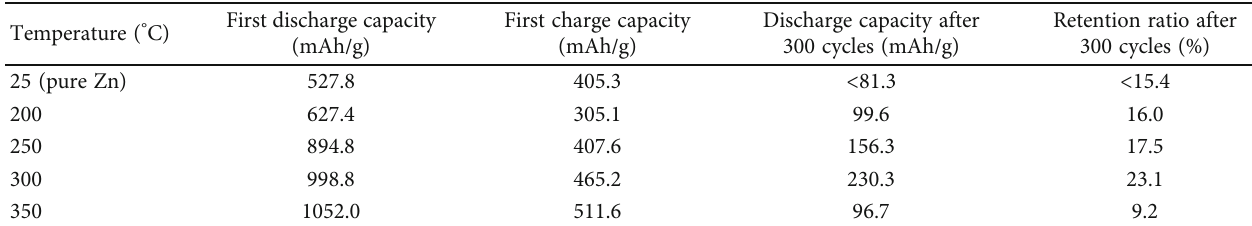
Figure 3: (a) FTIR spectra of ZnS and (b) UV spectrum of ZnS at 350 ° C. Table 1: Cycle performance of Zn/ZnS materials prepared at various sulfurization